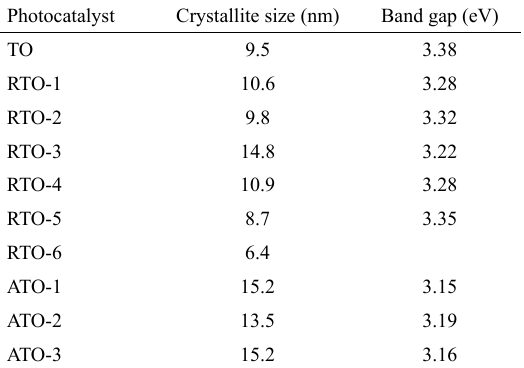
Table 2. Crystallite sizes and band gaps of different photocatalysts. Photocatalyst